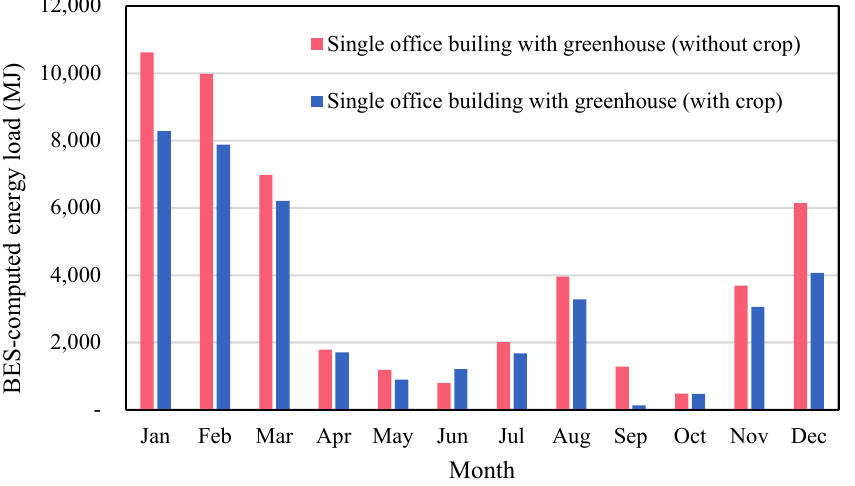
Figure 16. Comparison of monthly energy loads in the office building with a greenhouse, with and without crop.